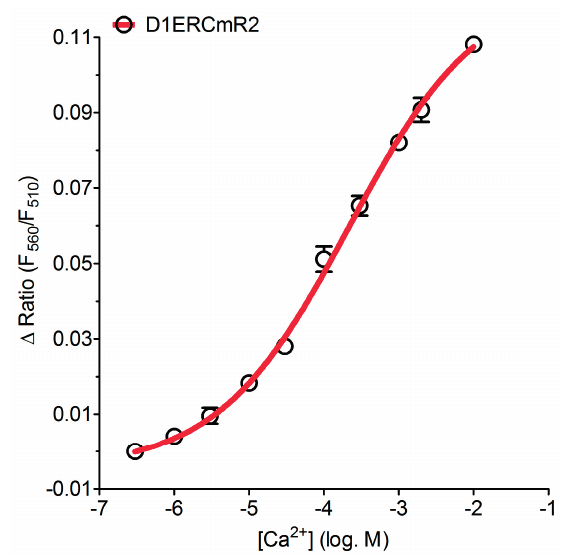
Figure 4. Determination of the K d in permeabilized HeLa cells expressing D1ERCmR2. [Ca 2+ ] was titrated to quantify the FRET ratio in percentage upon Ca 2+ -binding within D1ERCmR2 at 1 µM (n = 21), 3 µM (n = 21), 10 µM (n = 37), 30 µM (n = 37), 100 µM (n = 26), 300 µM (n = 43), 1 mM (n = 35), 2 mM (n = 17) and at 10 mM (n =